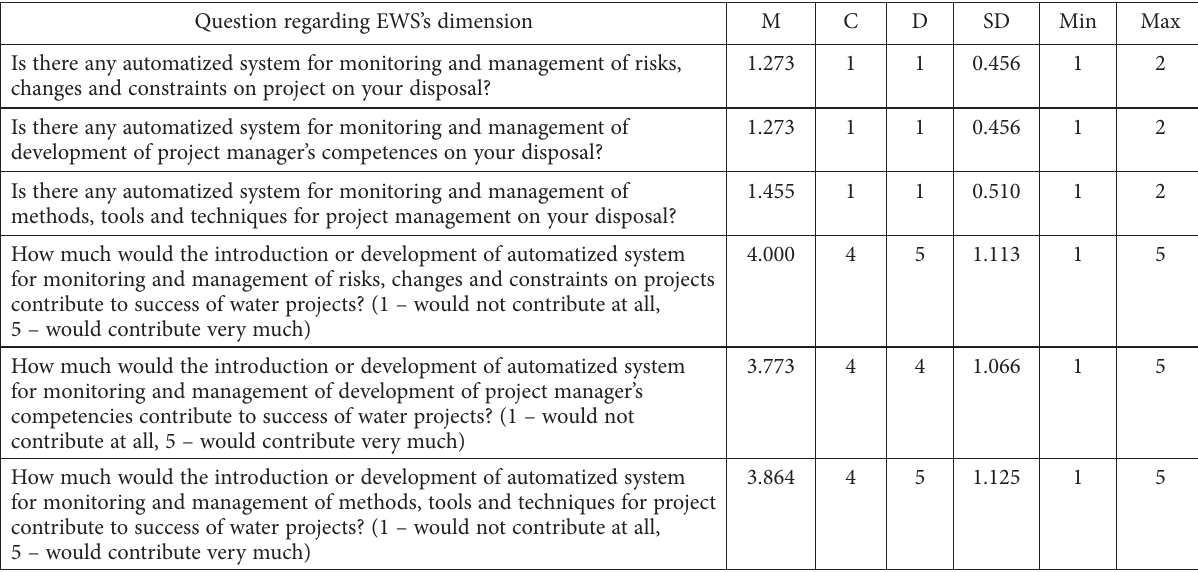
Table 11. Results on EWS dimensions’